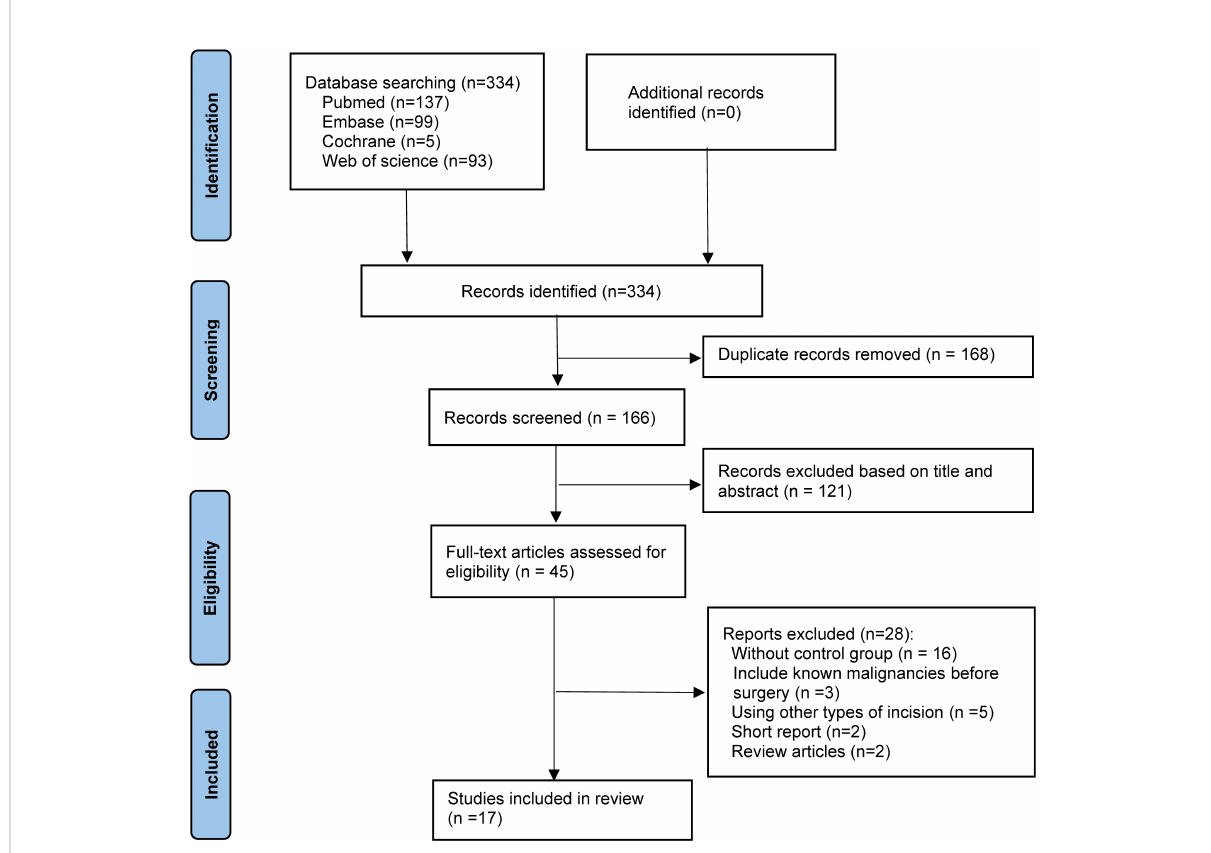
FIGURE 2 The Preferred Reporting Items for Systematic Reviews and network meta-analyses checklist (PRISMA-NMA)